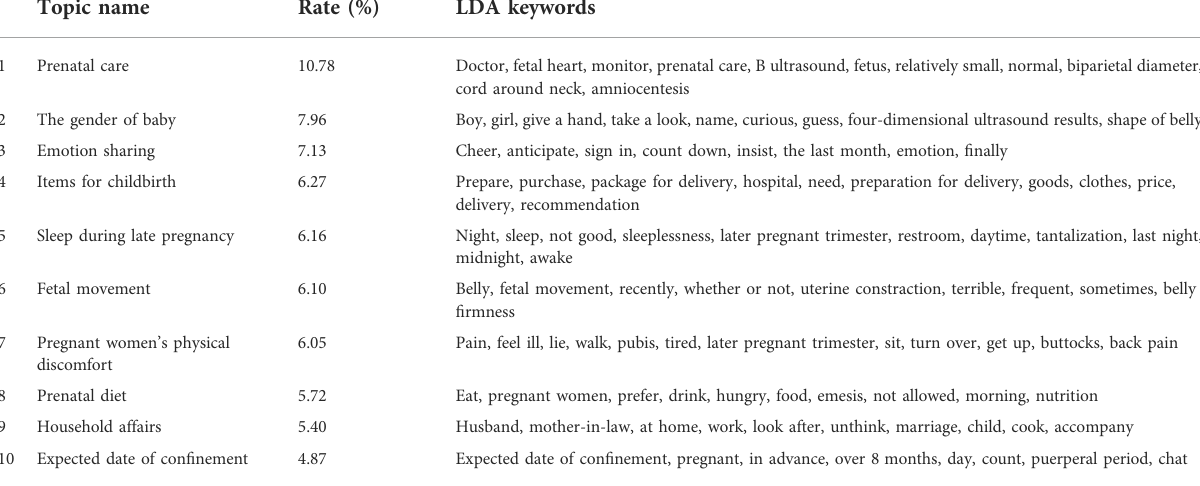
TABLE 12 Topics in the ninth month of pregnancy.